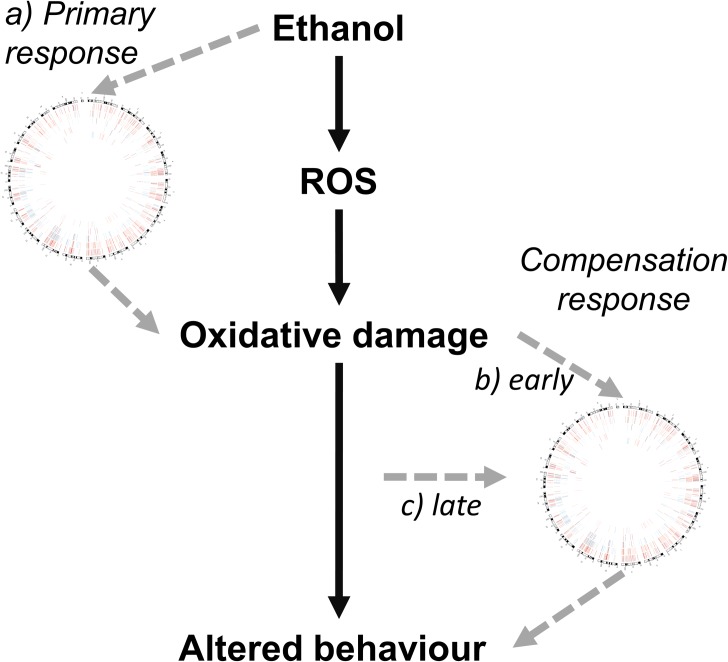
Potential origins of observed epigenetic and gene expression hippocampal profile in response to neonatal ethanol exposure.It is well established that in the brain ethanol leads to increased ROS, leading to oxidative damage, which contributes to altered behaviour. The epigenetic and gene expression changes identified here (represented by the Circos plot from Fig 1) may have arisen from: a) the direct action of ethanol during the exposure period, which may then act to perpetuate ethanol-induced oxidative damage; b) an early response to ethanol-induced oxidative cellular damage, acting to ameliorate or compensate for this damage; c) an later response to accumulating oxidative damage over the early life of the mouse, prior to 70 days of age.